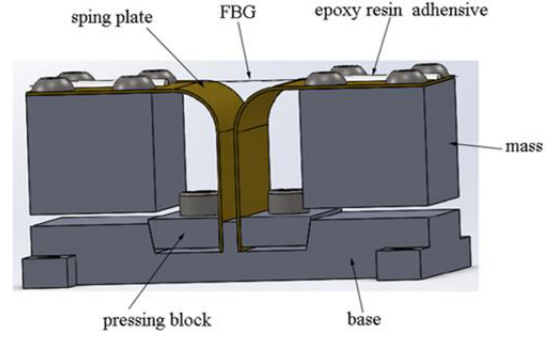
Figure 1. The schematic illustration of the accelerometer.